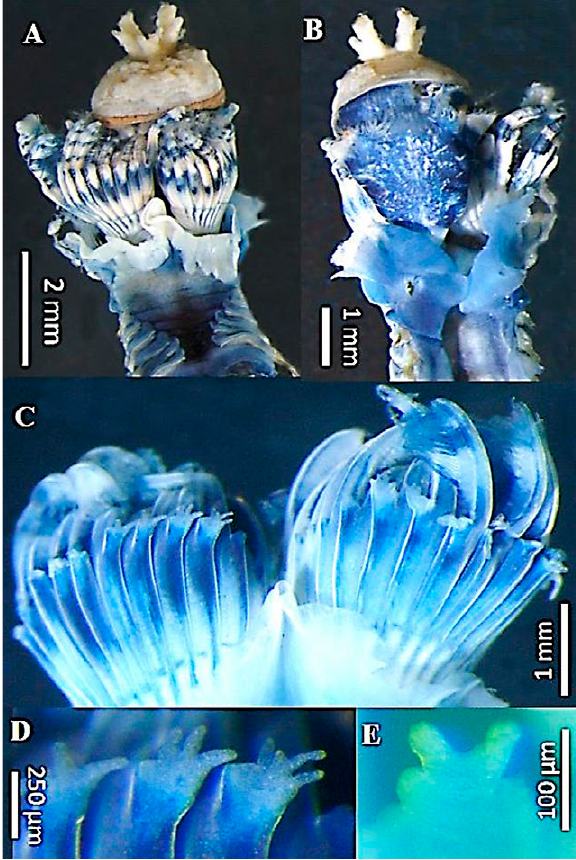
Fig. 3. – Spirobranchus cf. tetraceros from Valencia Port. A-B. Specimens in their tubes: A, lateral view; B, dorsal view. C, worms Fig. 4. – Spirobranchus cf. tetraceros (Valencia Port) removed from removed from their tubes (lateral and dorsal views). Abbreviation: its tube. A, ventral view. B, dorsal view. C-D, interradiolar mem- CC: collar chaeta. brane with multilobed processes. E, details of bilobed